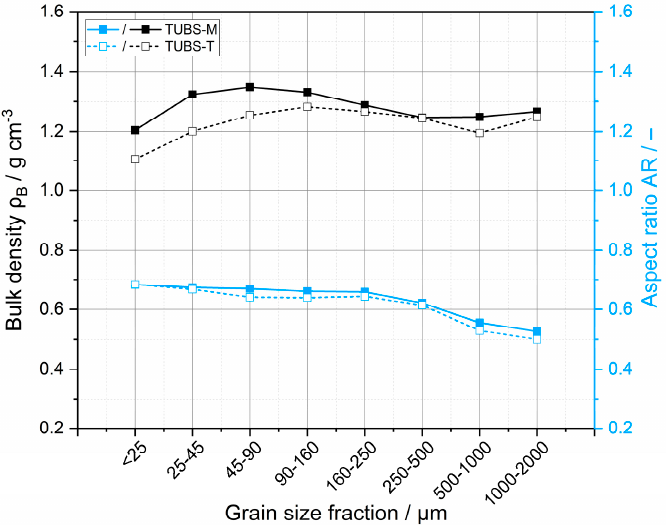
Figure 6. Average aspect ratio and bulk density of the grain size fractions of both simulant materials. There is little data available on the aspect ratio of real lunar regolith. Görz et al. [94,95] examined 2066 particles in the size range of 1.25–30 µm and reported that most values fall in the range of 0.4 to 0.7 (slightly-to-moderately elongated), which results in an average